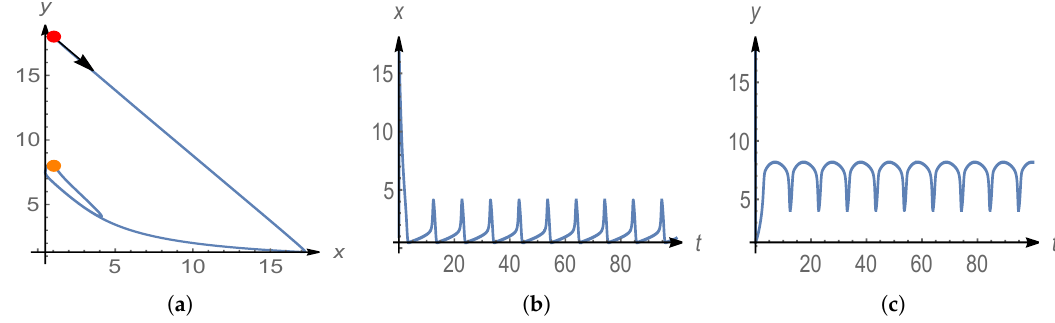
Figure 4. Model 1 with a stable outer and an unstable inner limit cycle. The trajectory is going inward, approaching the large limit cycle as t tends to + ∞ . The distance of the initial point from the singular point is d = 10.